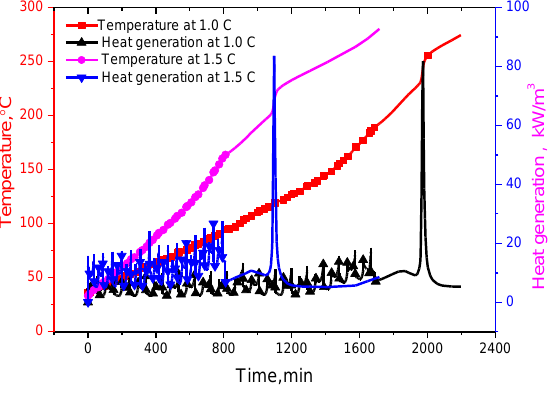
Figure 6. The temperature and heat resource changes under adiabatic conditions at the current rates of 1.0 C and 1.5 C, respectively.